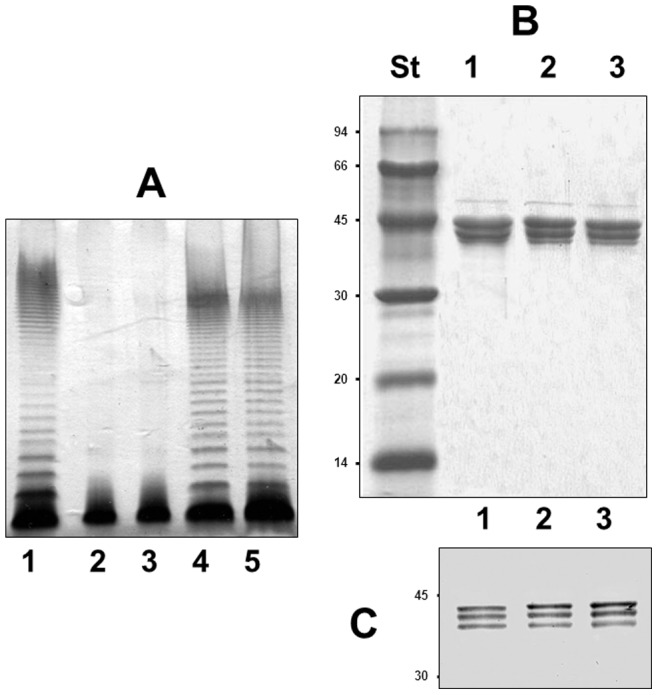
Purified polar flagellins from several A. hydrophila strains obtained according to Materials and Methods.A, LPS profiles of 1, A. hydrophila AH-3 (wild type); 2, A. hydrophila O− mutant AH-3ΔManC; 3, A. hydrophila O− mutant AH-3ΔWaaL [22], [23]; 4, AH-3ΔManC+pBAD-ManC and 5, AH-3ΔWaaL+pBAD-WaaL. B/SDS-PAGE and C/Western blot using specific antiserum against purified polar flagellins. St, size standard (14, 20, 30, 45, 60, and 94 kDa). 1, A. hydrophila AH-3 (wild type); 2, A. hydrophila O− mutant AH-3ΔManC; and 3, A. hydrophila O− mutant AH-3ΔWaaL [22], [23].